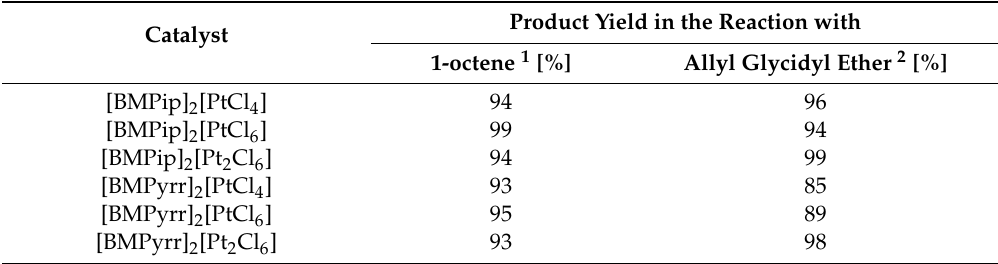
Table 3. The product yields in the reactions of hydrosilylation of 1-octene and allyl glycidyl ether